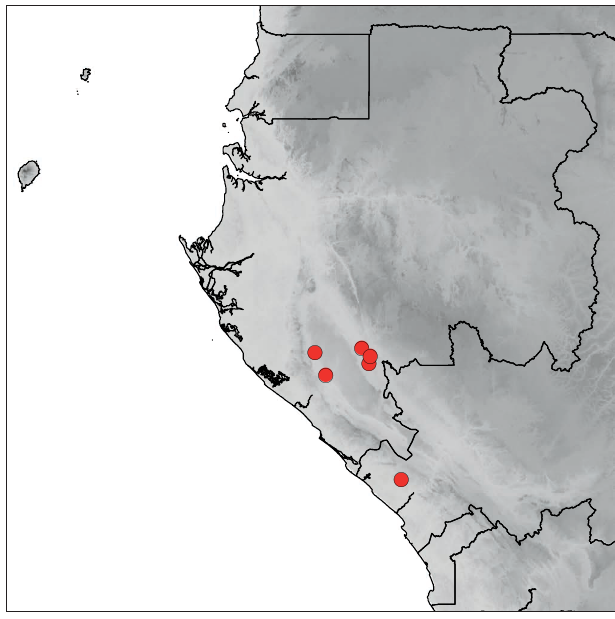
Figure 8 – Distribution of Kolobopetalum synsepalum . Map created with ArcMap 10.7.1 (ArcGIS Desktop v.10.7.1; Esri 2019). © Esri and its licensors, all rights